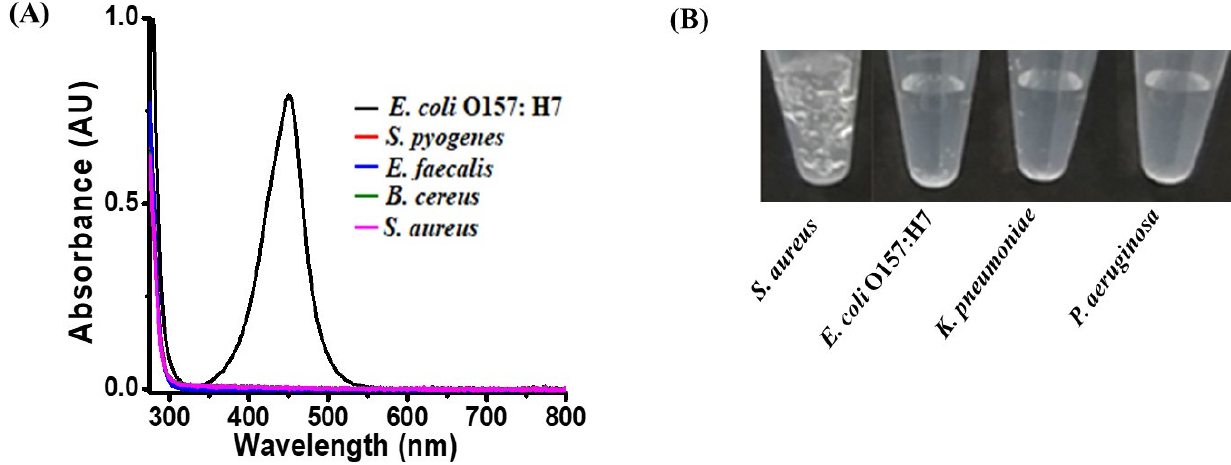
Figure 3. Examination of selectivity. ( A ) UV–Vis absorption spectra of the samples (0.2 mL) containing E. coli O157:H7, S. aureus, B. cereus, S. pyogenes , and E. faecalis prepared in the phosphate buffer at pH 3; spectra were obtained after reaction with TMB (1.25 mM) in the presence of H 2 O 2 (~11.2 mM) for 25 min, followed by the addition of sulfuric acid (2 M, 2 µL) to stop the reaction. All the model bacteria had the cell concentration of OD 600 equal to ~1. ( B ) Photograph of the samples (0.2 mL) containing S. aureus , E. coli O157:H7, K. pneumoniae , and P. aeruginosa (from left to right) prepared in the phosphate buffer at pH 3 and obtained after reaction with H 2 O 2 (180 mM) for 5 min. All the model bacteria had a cell concentration of OD 600 equal to ~1.